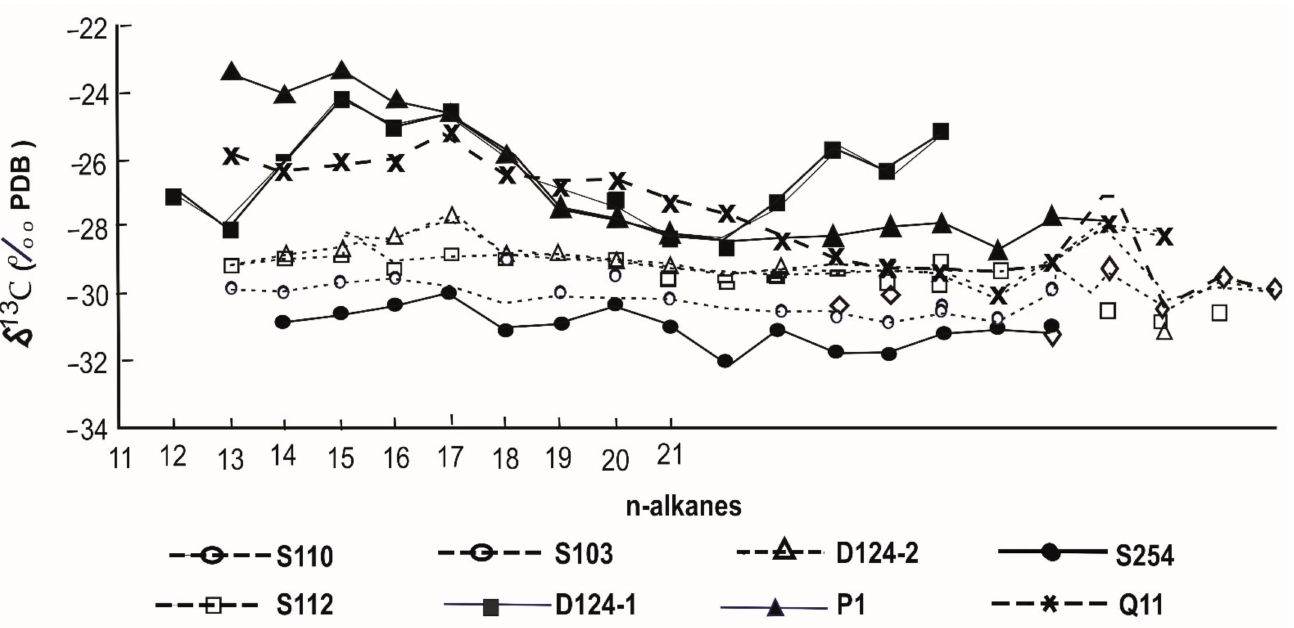
Figure 7. Carbon isotopic compositions of individual n-alkanes in source rocks of the.Western depression of the Liaohe Basin (Reproduced from [151] with permission from